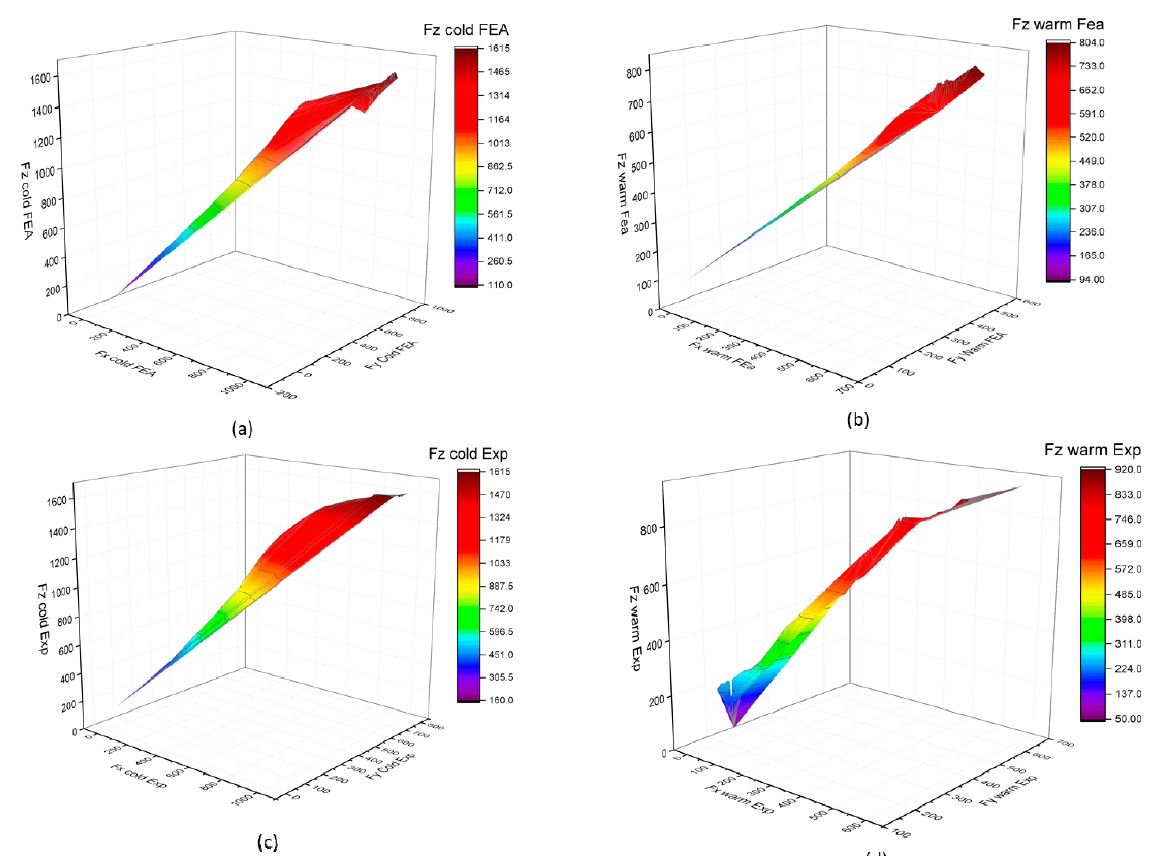
Figure 13. Three-dimensional surface plots of various force components during forming: ( a ) for CISF in FEA, ( b ) for WISF in FEA, ( c ) for experimental CISF, and ( d ) for experimental WISF.